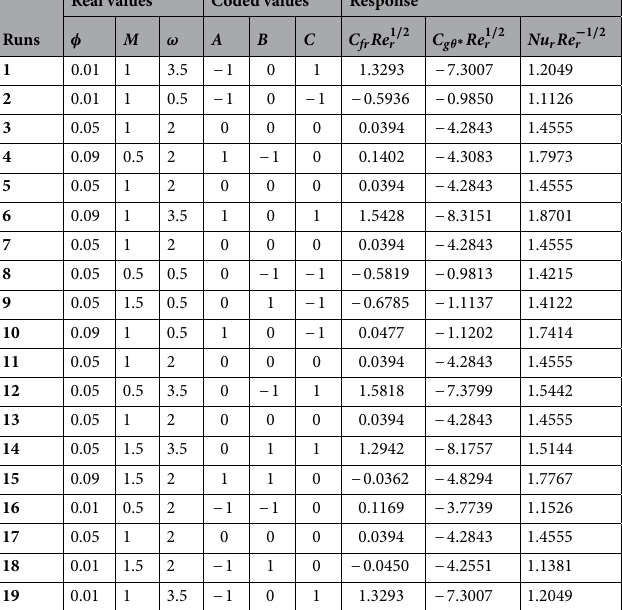
Table 5. Box–Behnken design with 5 center points is presented as real and coded values. Against each combination of parameters the response C fr Re